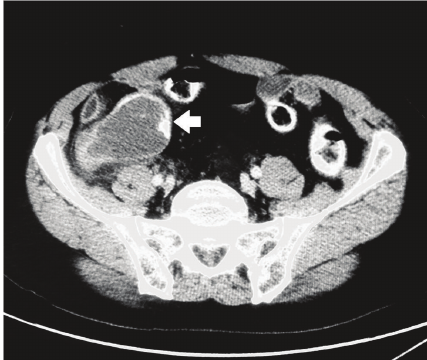
Figure 1: Mucocele of the appendix with wall calcification (white arrow).